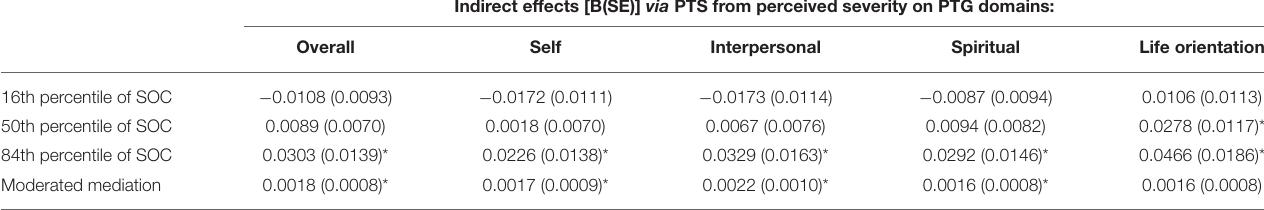
TABLE 5 | Conditional indirect effects on post-traumatic growth at 16th, 50th, and 84th percentile of SOC and magnitudes of the moderated mediation ( N = 372). Indirect effects [B(SE)] via PTS from perceived severity on PTG